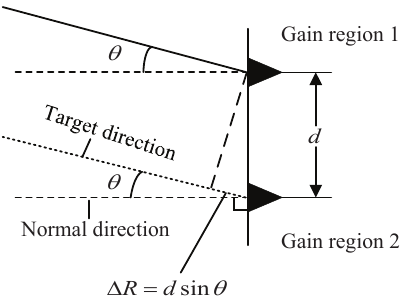
Figure 2. The plane model of the proposed method on planar array